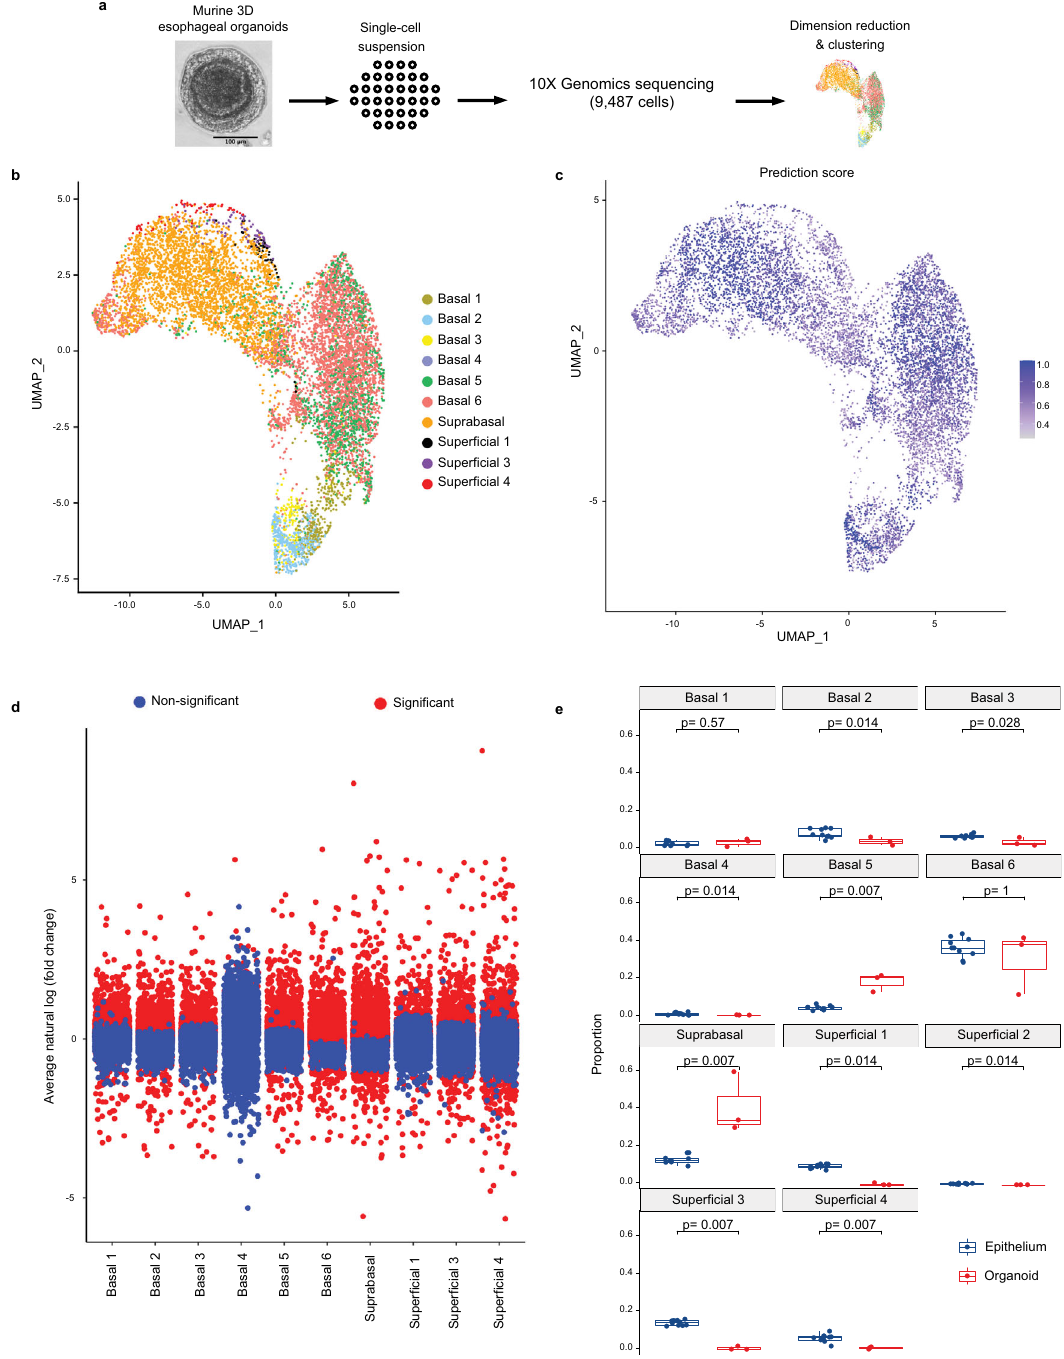
Fig. 5 Imputation of cell populations identi fi ed in murine esophageal epithelium in 3D murine esophageal organoids. a Schematic overview of experimental design of single cell RNA-Sequencing (scRNA-Seq) from murine esophageal organoids established from mice ( n = 3 independent experiments) and cultured for 15 days. Scale bar, 100 µ m. b Seurat ’ s Uniform Manifold Approximation and Projection (UMAP) was used to visualize cell clusters within the epithelial dataset. c Prediction scores (based on con fi dence scale ranging from 0 to 1) of each cell population identi fi ed in organoids using classi fi cations derived from murine esophageal epithelial scRNA-Seq dataset. Color intensity re fl ects the relative con fi dence that the predicted cluster identity is accurate with purple indicating cells with highest prediction con fi dence. d Average natural log fold change (FC) of individual genes in indicated cell population from murine 3D organoids as compared to the murine esophageal epithelial dataset. Genes marked as signi fi cant (indicated in red) have p < 0.05. e Comparison of proportions of each epithelial cluster in murine epithelial dataset ( n = 10 animals) and 3D organoids ( n = 3 independent experiments). Indicated p values in ( d , e ) were determined using Wilcoxon signed-rank test without adjustment for multiple comparisons. Each individual scatter point represents proportion indicated, box indicates quartiles, whiskers indicate minima and maxima. Mean is indicated by line striking through box. Source data are provided as a Source Data fi